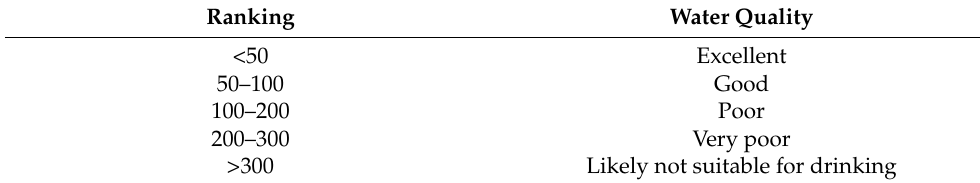
Table 1. Classification of the water quality index